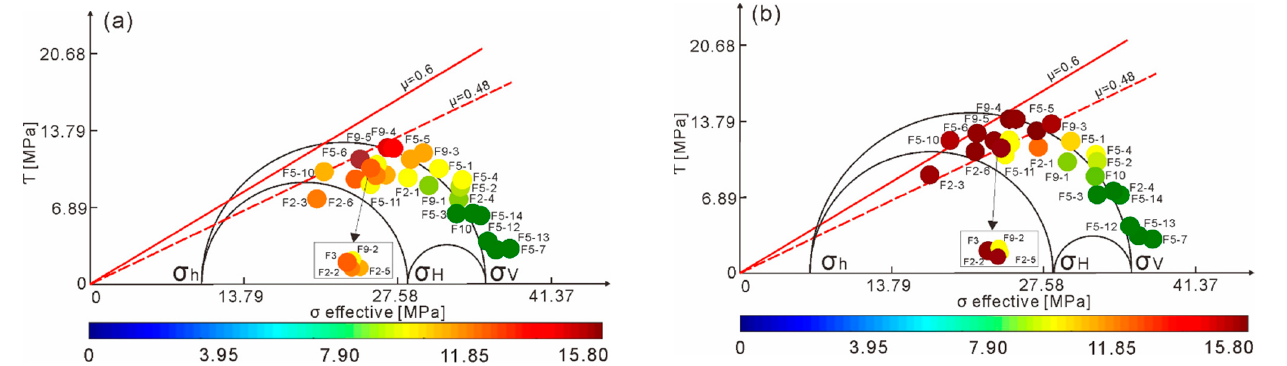
Figure 14. The pore pressure changes required to produce a slip on the main active faults in the Rongcheng deep geothermal reservoir at a reference depth of 2600 m. ( a ) Not including the temperature change in the minimum horizontal principal stress caused by 20 years of water injection; ( b ) considering the influence of thermoelastic stress in the minimum horizontal principal stress due to twenty years of fluid injection.